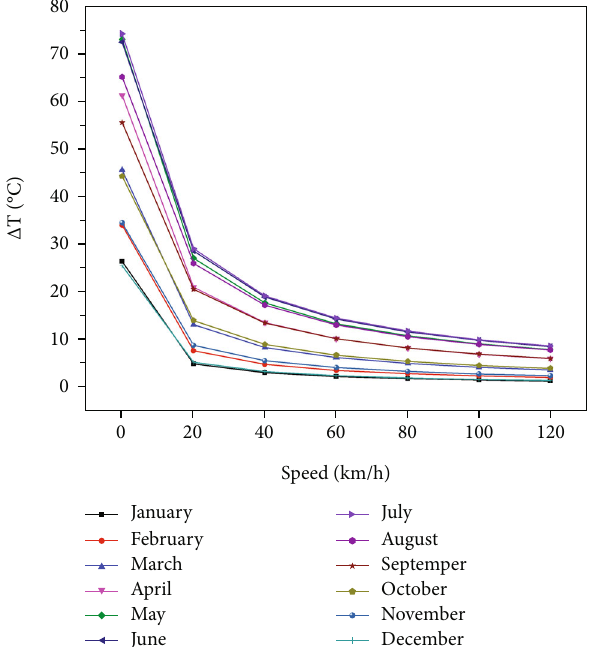
Figure 12: Δ T − v diagram for di ff erent